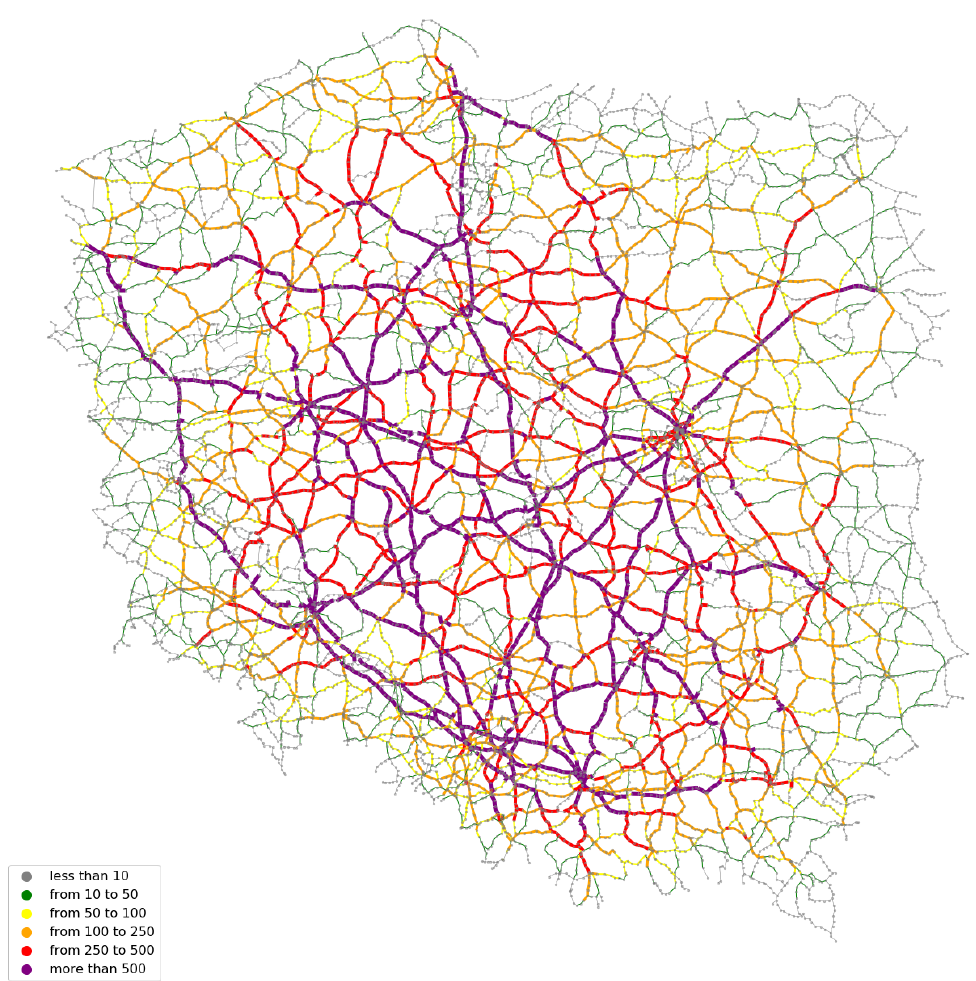
Figure 6. Results of the assessment of traffic volumes for domestic trips. Table 3. Sample structure of traffic volumes generated by domestic trips.